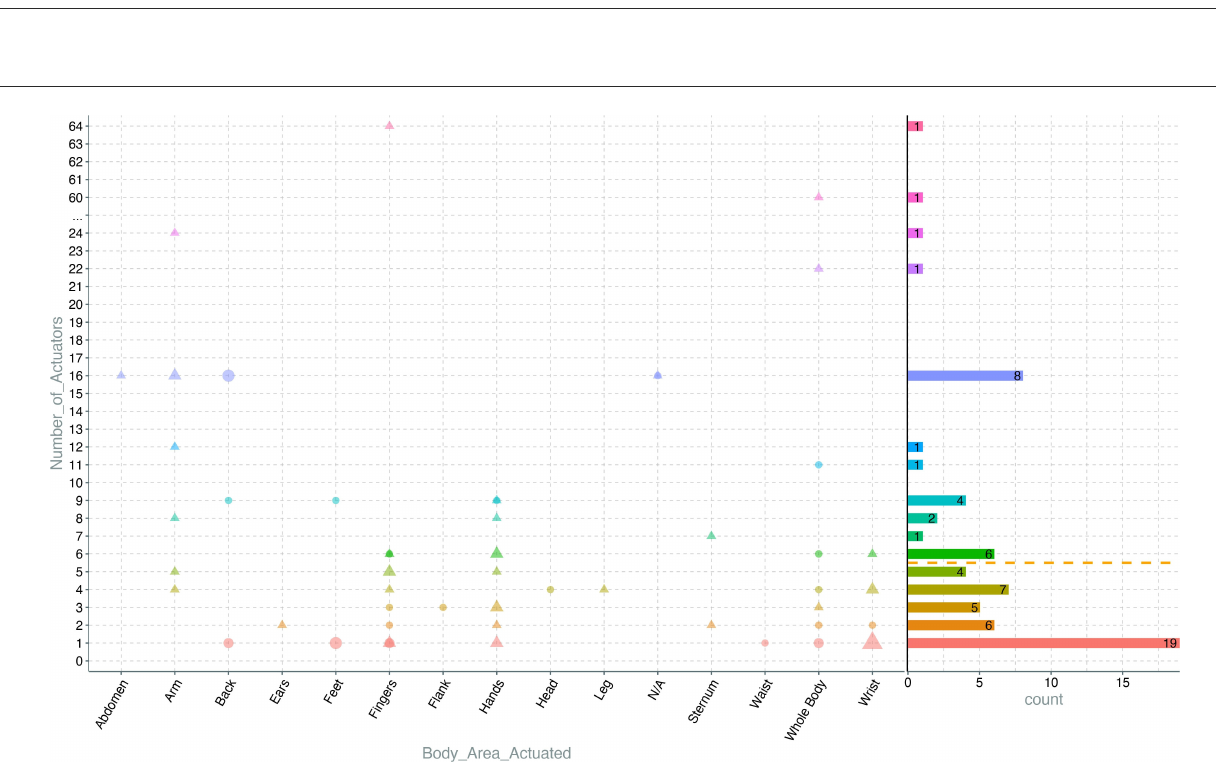
FIGURE12 Distribution of number of actuators over the body area they actuate; a triangle indicate a wearable device, a circle indicates a fixed device and the size of the shape represents the amount of similar devices. The dashed orange line represents the